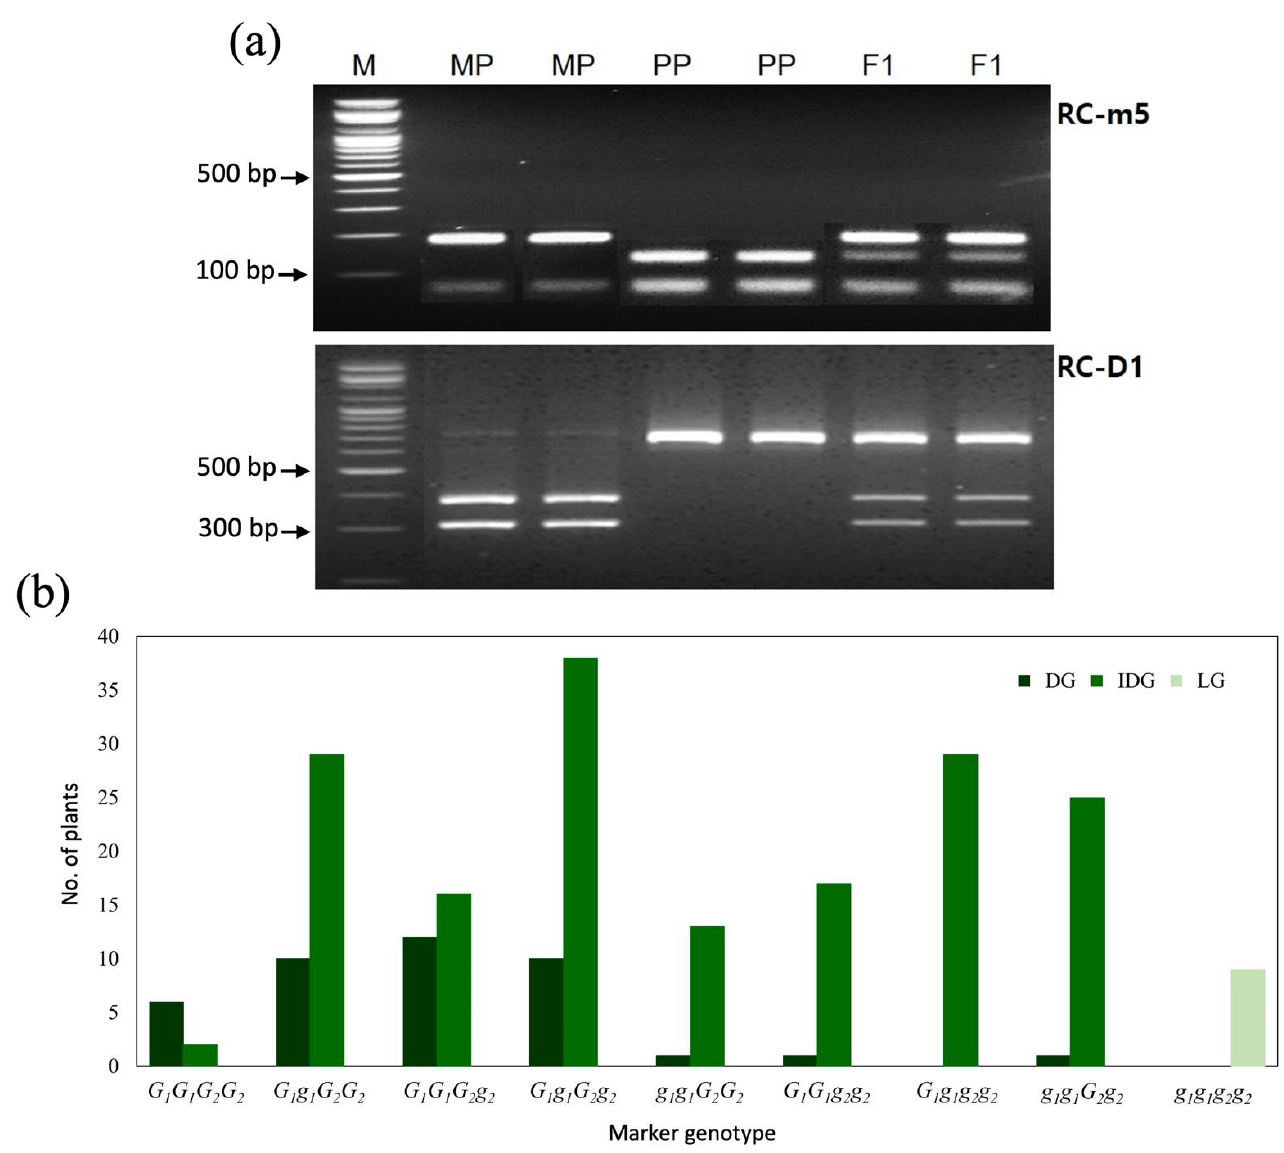
Figure 3. ( a ) Agarose gel image of CAPS marker RC-m5 at G 1 (RC-QTL-C6) and RC-D1 at G 2 (RC-QTL-C8) for the rind color of watermelon fruit. M, 100 bp size marker; MP, maternal parent ‘FD061129’; PP, paternal parent ‘SIT55616RN’; F 1 , progeny from the cross between MP and PP; ( b ) Distribution of F 2 plants for rind color based on the classification of marker genotypes of RC-m5 and RC-D1. G 1 and g 1 , allele for dark green and light green rind color, respectively, at the locus RC-QTL-C6; G 2 and g 2 , allele for dark green and light green rind color, respectively, at the locus RC-QTL-C8. Among 210 F 2 plants with DG or IDG, 171 showed the marker genotype for ‘SIT55616RN’ ( G 1 G 1 ) or heterozygosity ( G 1 g 1 ), whereas the remaining 39 showed the marker genotype for ‘FD0611 2 ’ ( g 1 g 1 ). All nine F 2 plants with LG RC showed marker